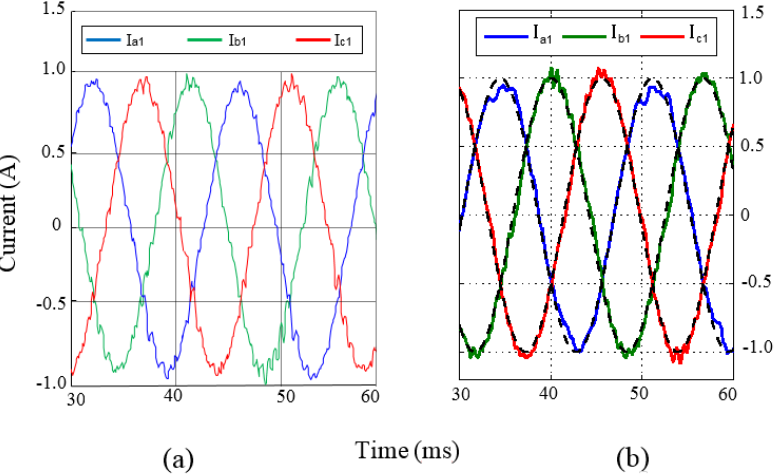
Figure 16. The three-phase current of the system: ( a ) for the six-leg inverter and ( b ) for the four- leg